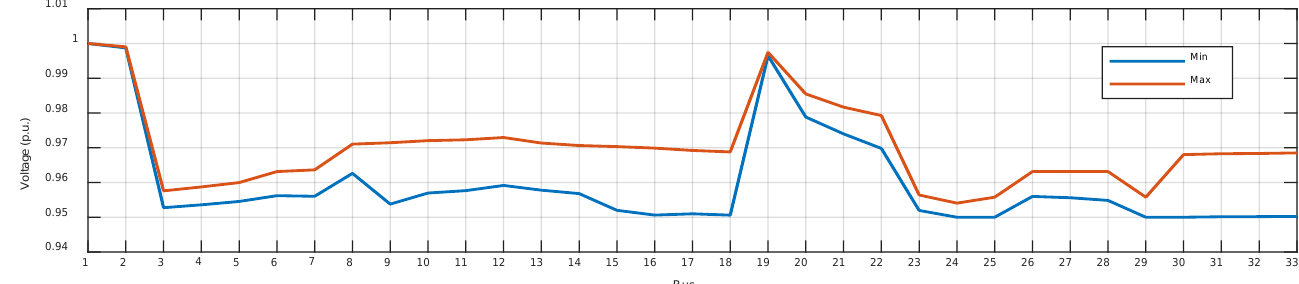
Figure 9. Boxplot representation of hourly voltage profiles for Scheme I.